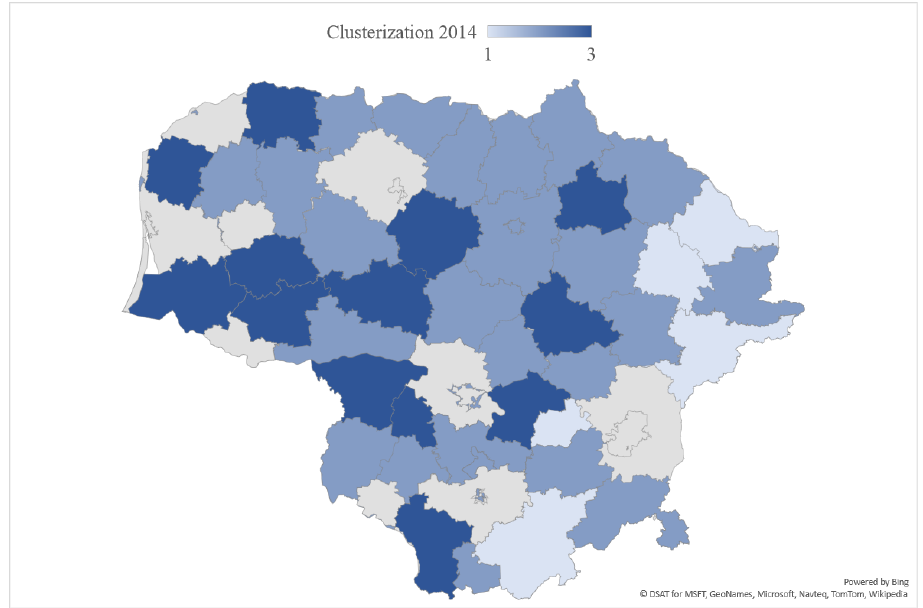
Figure 2. The results of clustering applying clusters analysis of 2014.